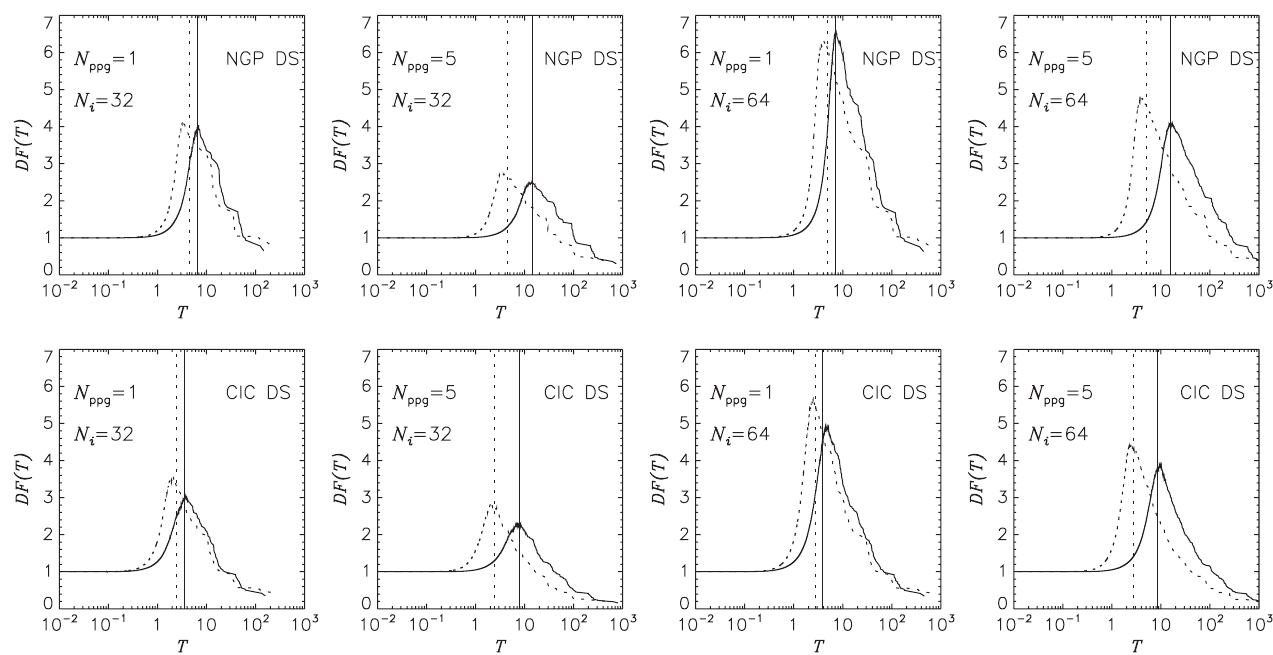
FIG. 9. Denoising factor (DF), defined in Eq. (35), as a function of the threshold T for the superimposed Gaussian model with: (cid:4) 32 and N (cid:4) 1 (first column); N (cid:4) 32 and N (cid:4) 5 (second column); N N i i ppg ppg (cid:4) 5 (fourth column). Daubechies wavelets of order 2 were used. The NGP DS is given in the top row, and the CIC DS in the N ppg bottom. Dashed lines represent thresholding with Anscombe transformation, and solid lines thresholding without Anscombe trans- formation. The vertical lines denote their corresponding thresholds predicted by Eqs. (41)–(44): T (dashed lines) and ~ T (solid lines) in the bottom lines) in the top row, and T CIC CIC